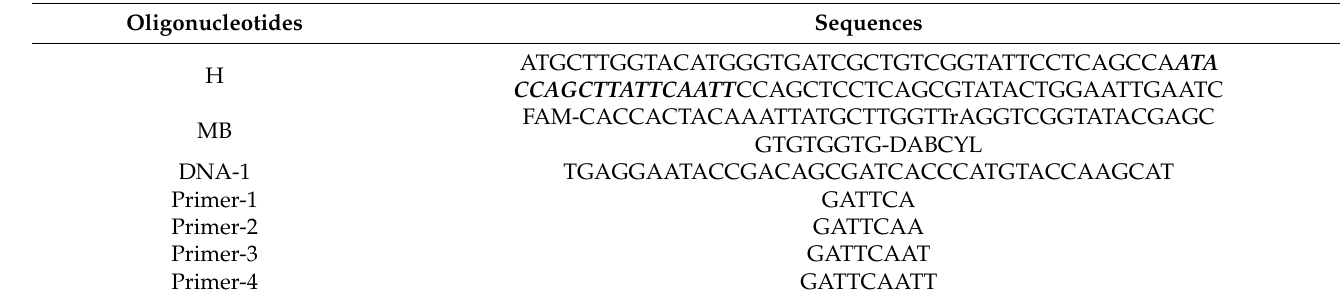
Table 1. Oligonucleotide sequences (5 (cid:48) → 3 (cid:48) ). Oligonucleotides